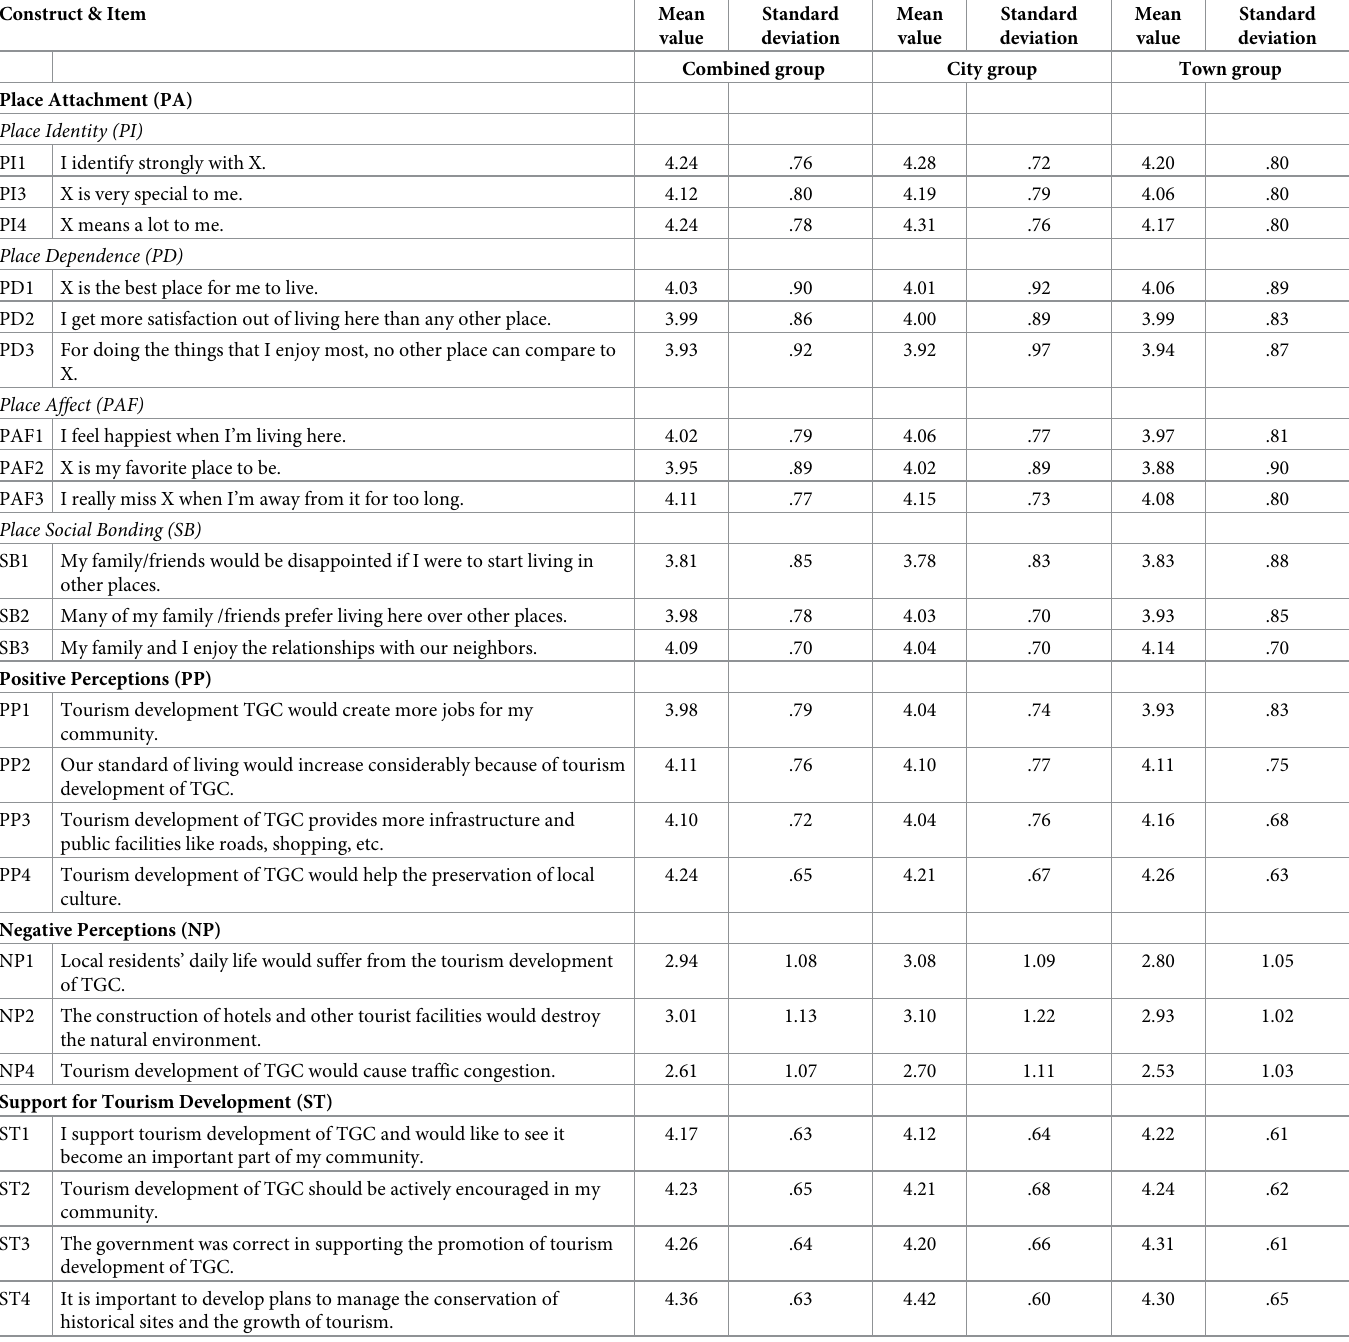
[80,86,87]; and average of variance extracted (AVE) values of all constructs (Table 5) were higher than the recommended threshold of 0.50 [75,81] with one exception of 0.41, while greater than 0.36 was acceptable according to Fornell and Larcker [81]. These values